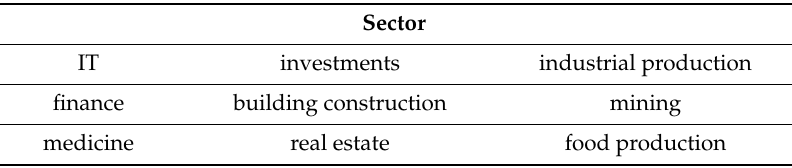
Table 4. Sector included in the study as a binary